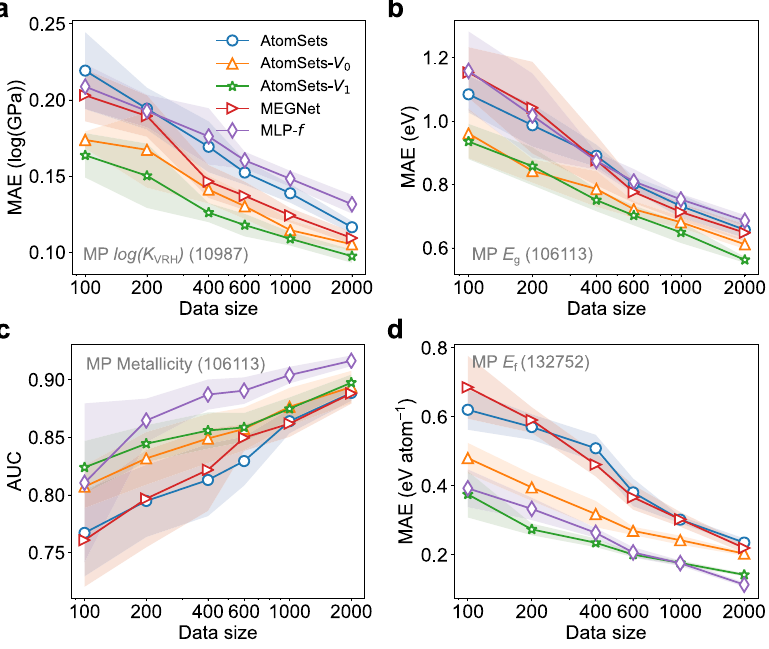
Fig. 3 Model convergence in the small data limits. The four datasets are the ( a ) log10 of the bulk moduli, ( b ) band gap, ( c ) binary metallicity, and ( d ) formation energy structural datasets from the Materials Project. The shaded areas are the standard deviation across fi ve random data fi